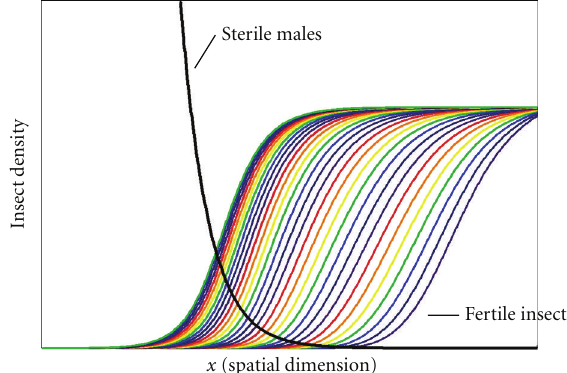
Figure 2: A barrier of sterile male insects theoretically stops a “travelling wave” of fertile insects in a determinable fashion.